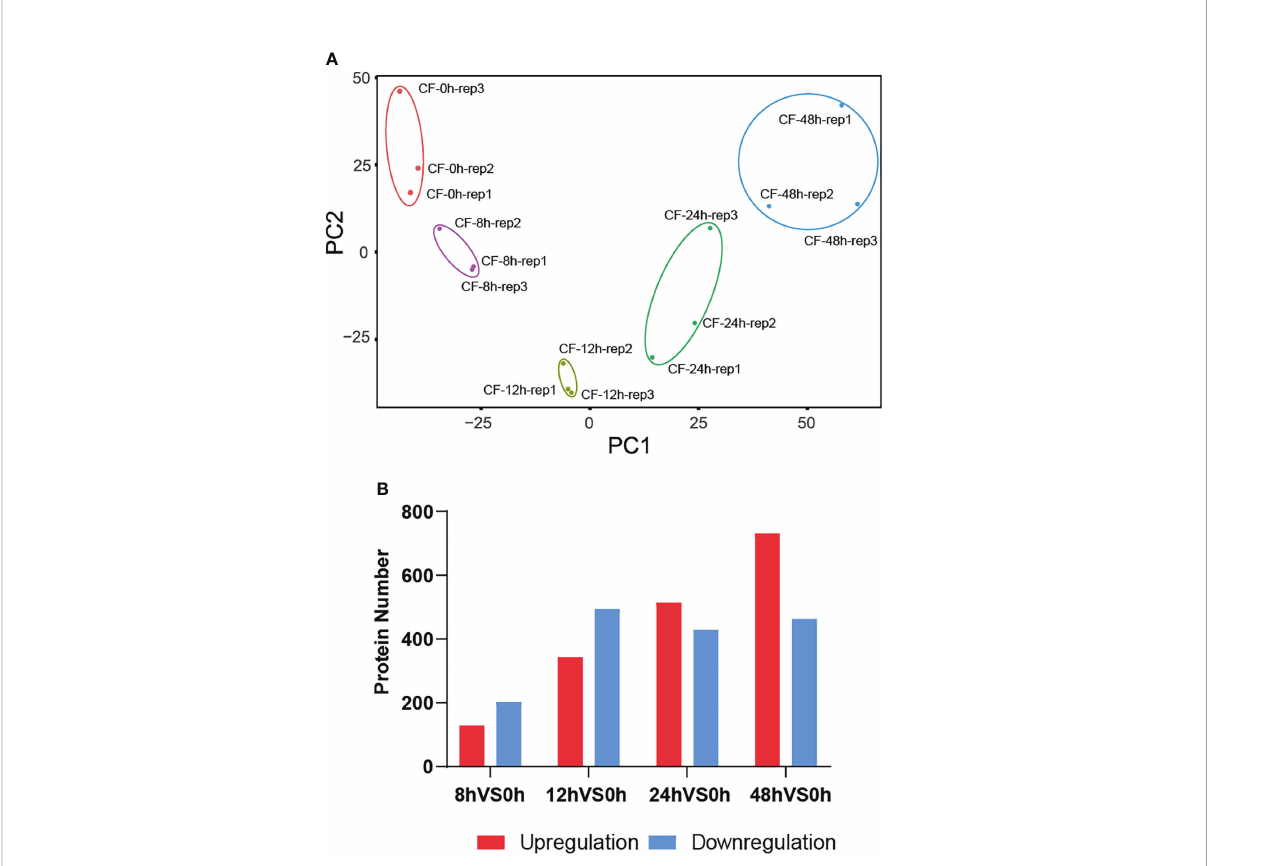
FIGURE 3 A total of 1429 DEPs were identi fi ed. The principal component analysis (PCA) biplot shows that CF-induced proteins at fi ve time points 0, 8, 12, 24, 48 hpi were distinctly separate in two principal components (A) , and they were differentially expressed at 8, 12, 24, 48 hpi compared to their expression at 0 hpi (B) .